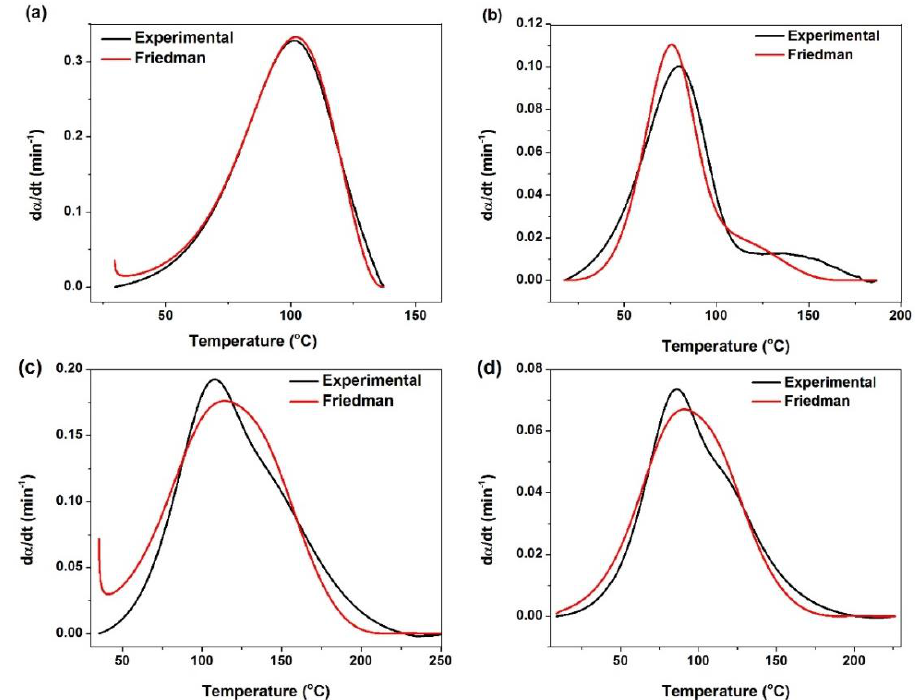
Figure 12. Comparison of experimental data with the kinetic models for ( a ) neat epoxy, ( b ) epoxy / P-HNT, ( c ) epoxy / A-HNT and ( d ) epoxy / F-HNT based on Friedman model.